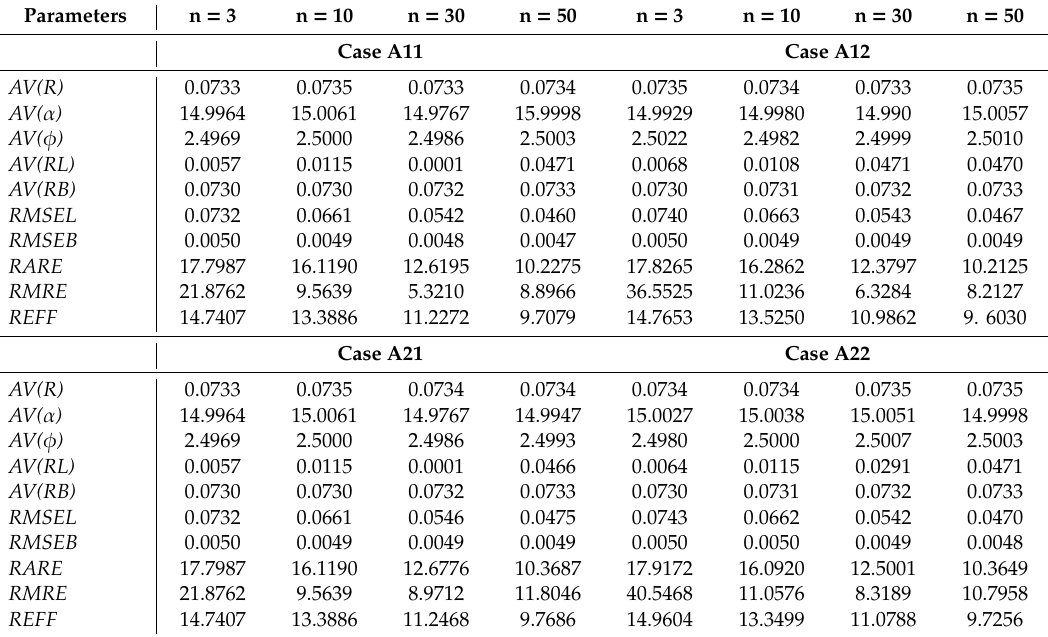
Table 3. Simulation results for cases